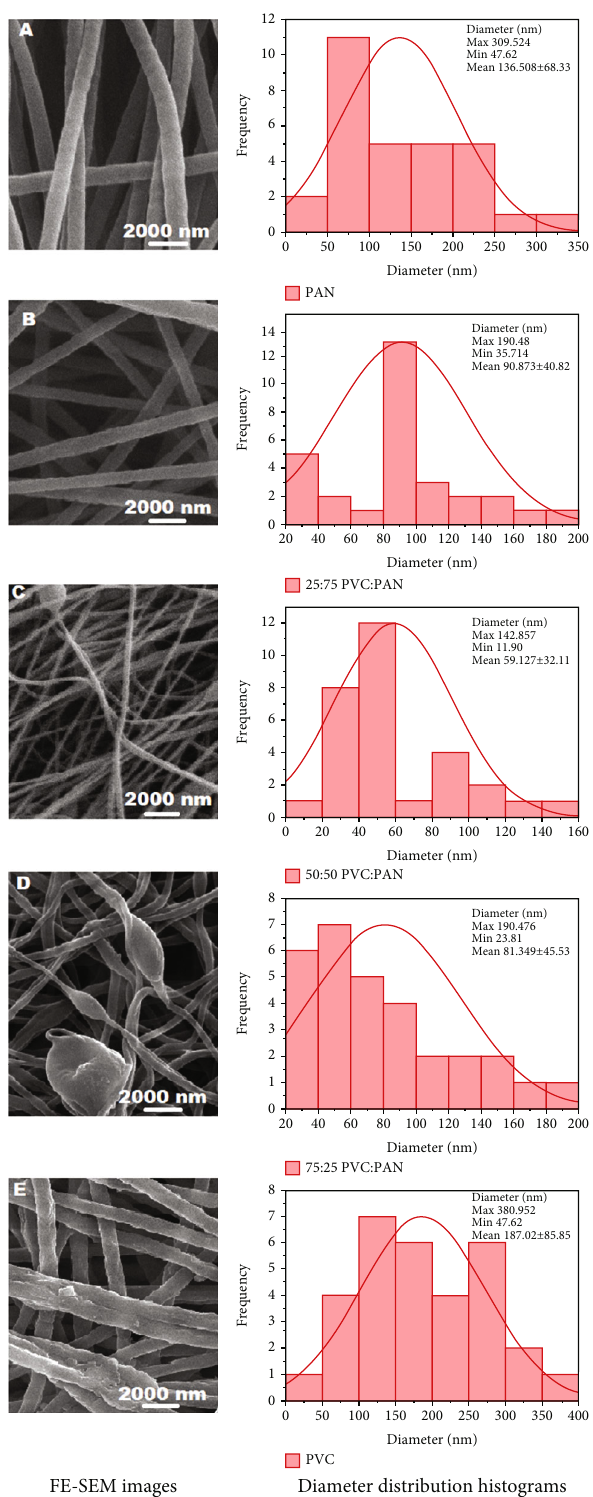
Figure 4: FE-SEM images and diameter distribution histograms for (a) pure PAN, (b) 25:75, (c) 50: 50, (d) 75:25 PVC: PAN, and (e) pure PVC nano fi